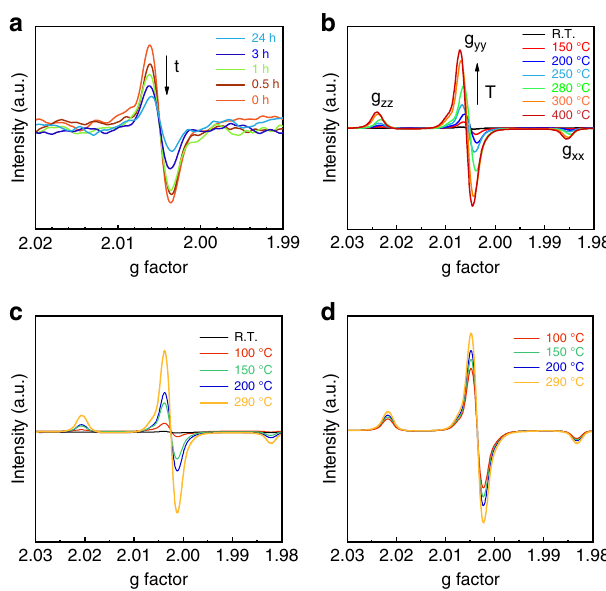
Fig. 1 EPR patterns of the N-doped TiO 2 photocatalysts. a N-doped TiO 2 N- P25-550 (freshly prepared) at different times. After being treated in NH 3 at 550 °C for 8 h, the EPR of the freshly made sample was measured immediately. Then more EPR spectra were also collected after the sample was exposed to air for 0.5, 1, 3 and 24 h. b Deactivated N-P25-550 after recalcination in N 2 at different temperatures; N-P25-550 quenched from c liquid water and d water vapour at different